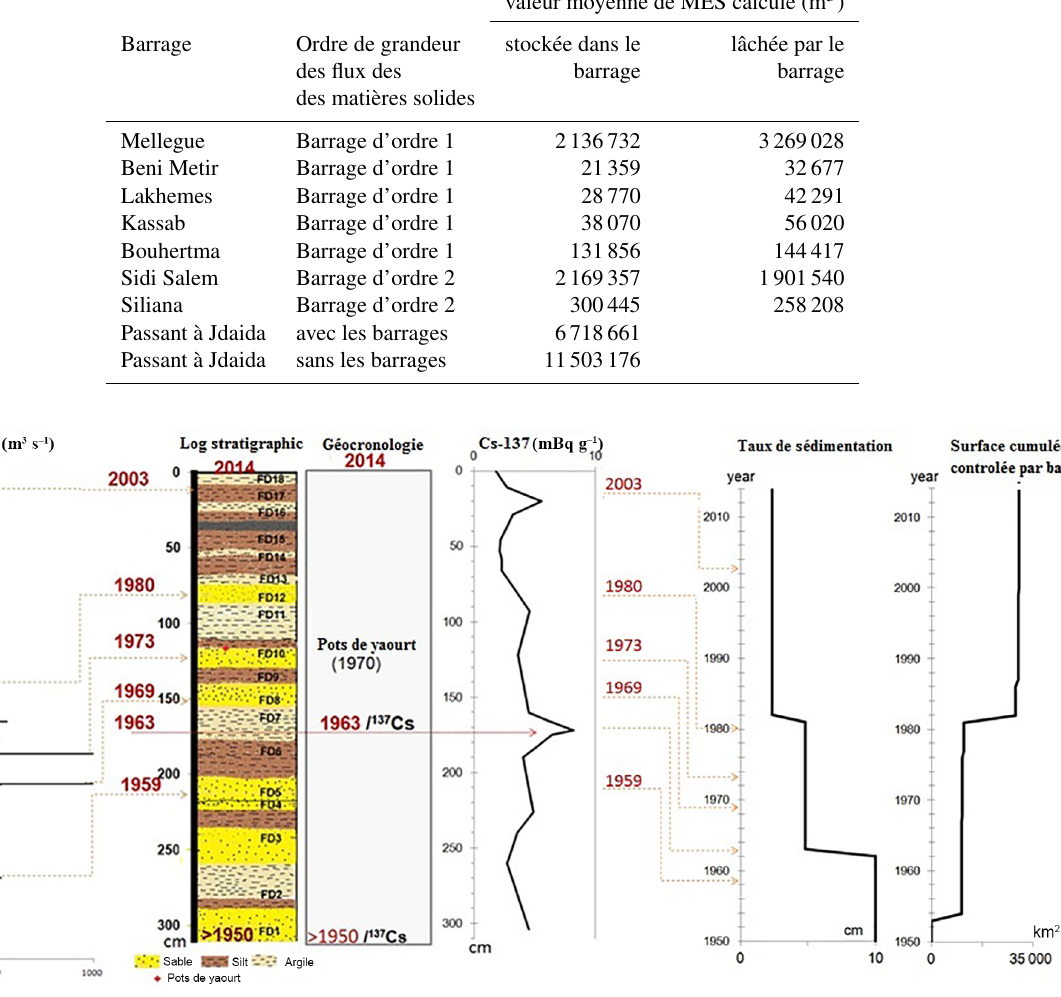
Figure 4. Reconstitution historique des apports sédimentaire par les traceurs chronologiques ( 137 Cs) et la comparaison des enregistrements de débit maximum annuel au niveau de la station hydrométrique de